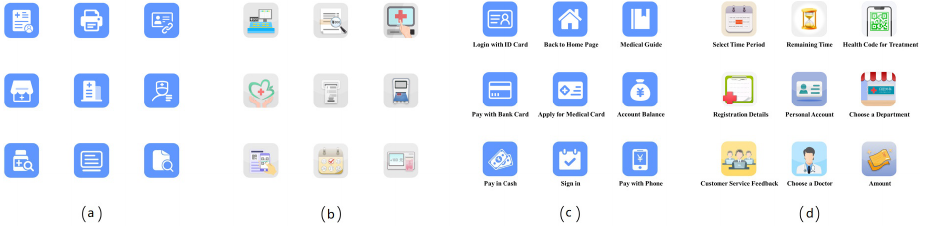
Figure 2. Examples of different groups of experimental materials. ( a ) Flat icons (FIs); ( b ) skeuomorphic icons (SIs); ( c ) FIs plus text; ( d ) SIs plus text.